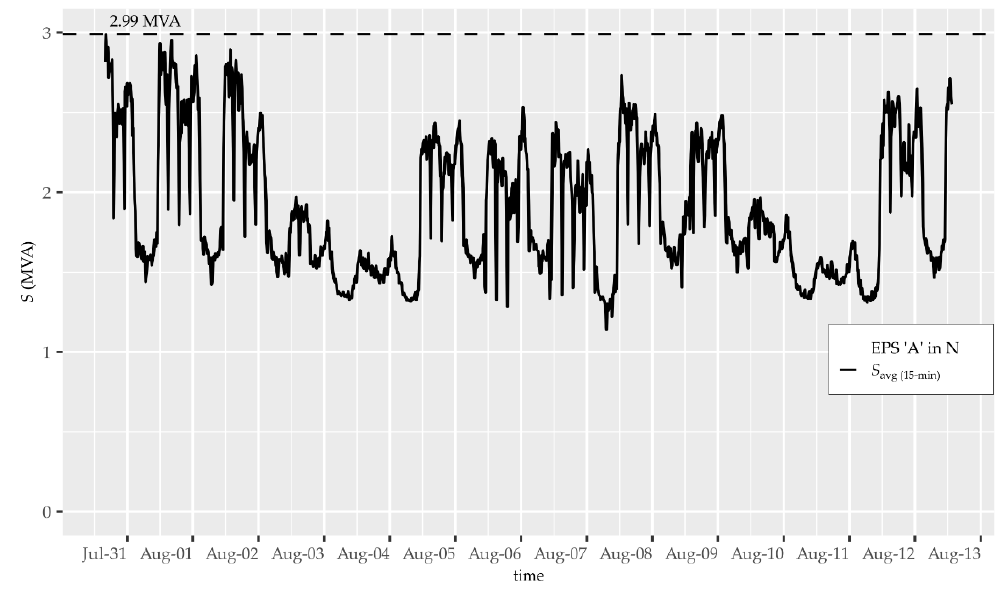
Figure 11. The S EPS “A” profile of the EPS “A” substation in the normal operating condition N. In this condition, the substation supplies energy consumers in a large rural area as well as a single large recipient, the industrial plant “IP” (see Figure 1).